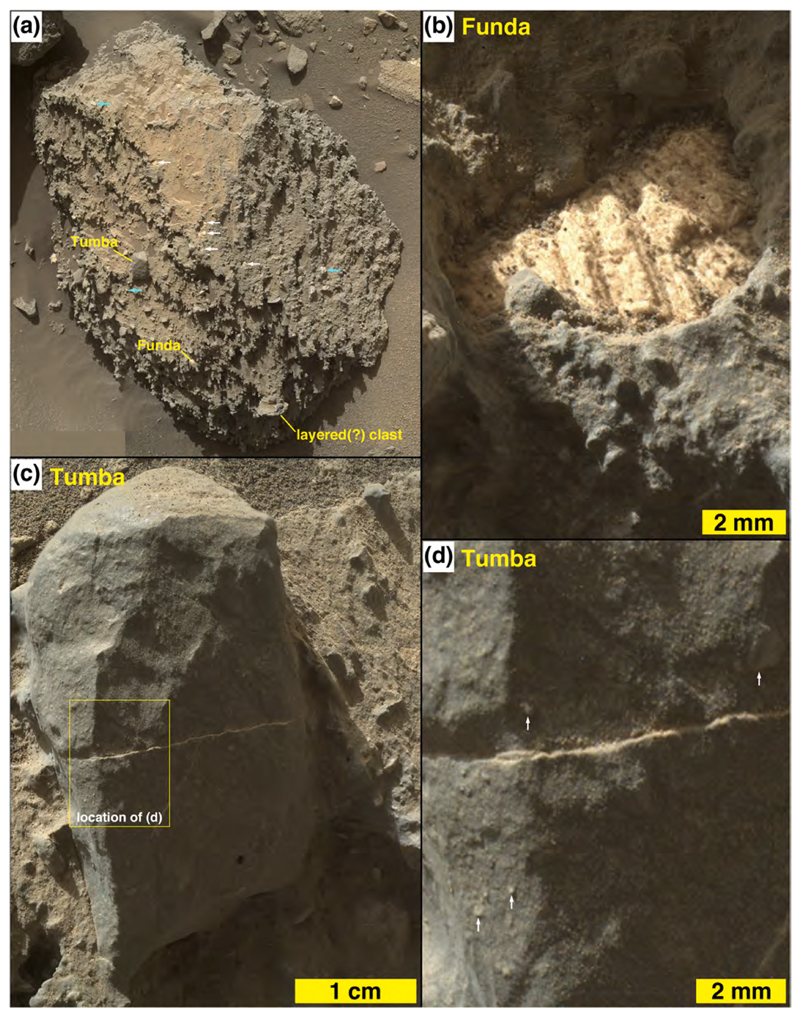
(a) Conglomeratic boulder that includes the APXS/MAHLI target, Funda, and the MAHLI target, Tumba. White arrows indicate recessed white objects similar to Funda; blue arrows indicate light-gray and white protrusive pebble clasts. (b) Close-up view of white, recessed, banded object (clast or void fill) comprising the target Funda. (c) Pebble clast target named Tumba. (d) Close-up view of a portion of the Tumba pebble clast, showing that it is a sandstone; arrows point to a few example grains. (For interpretation of the references to color in this figure, the reader is referred to the web version of this article.)